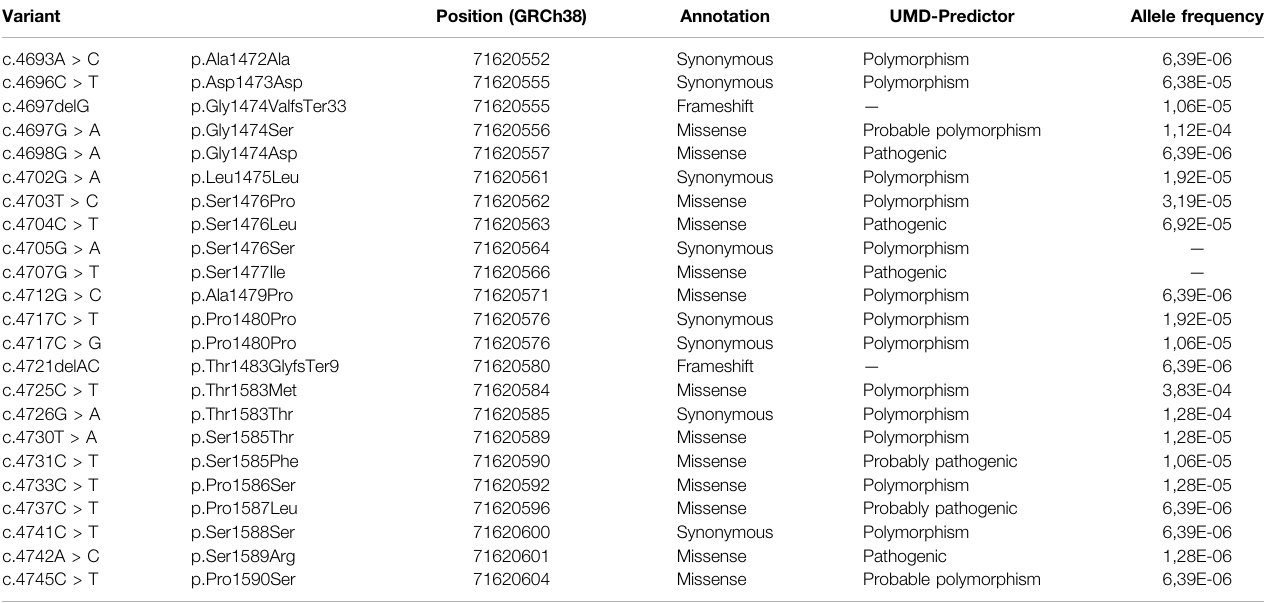
TABLE 2 | Exon 40a variant referenced in gnomAD and Kaviar.